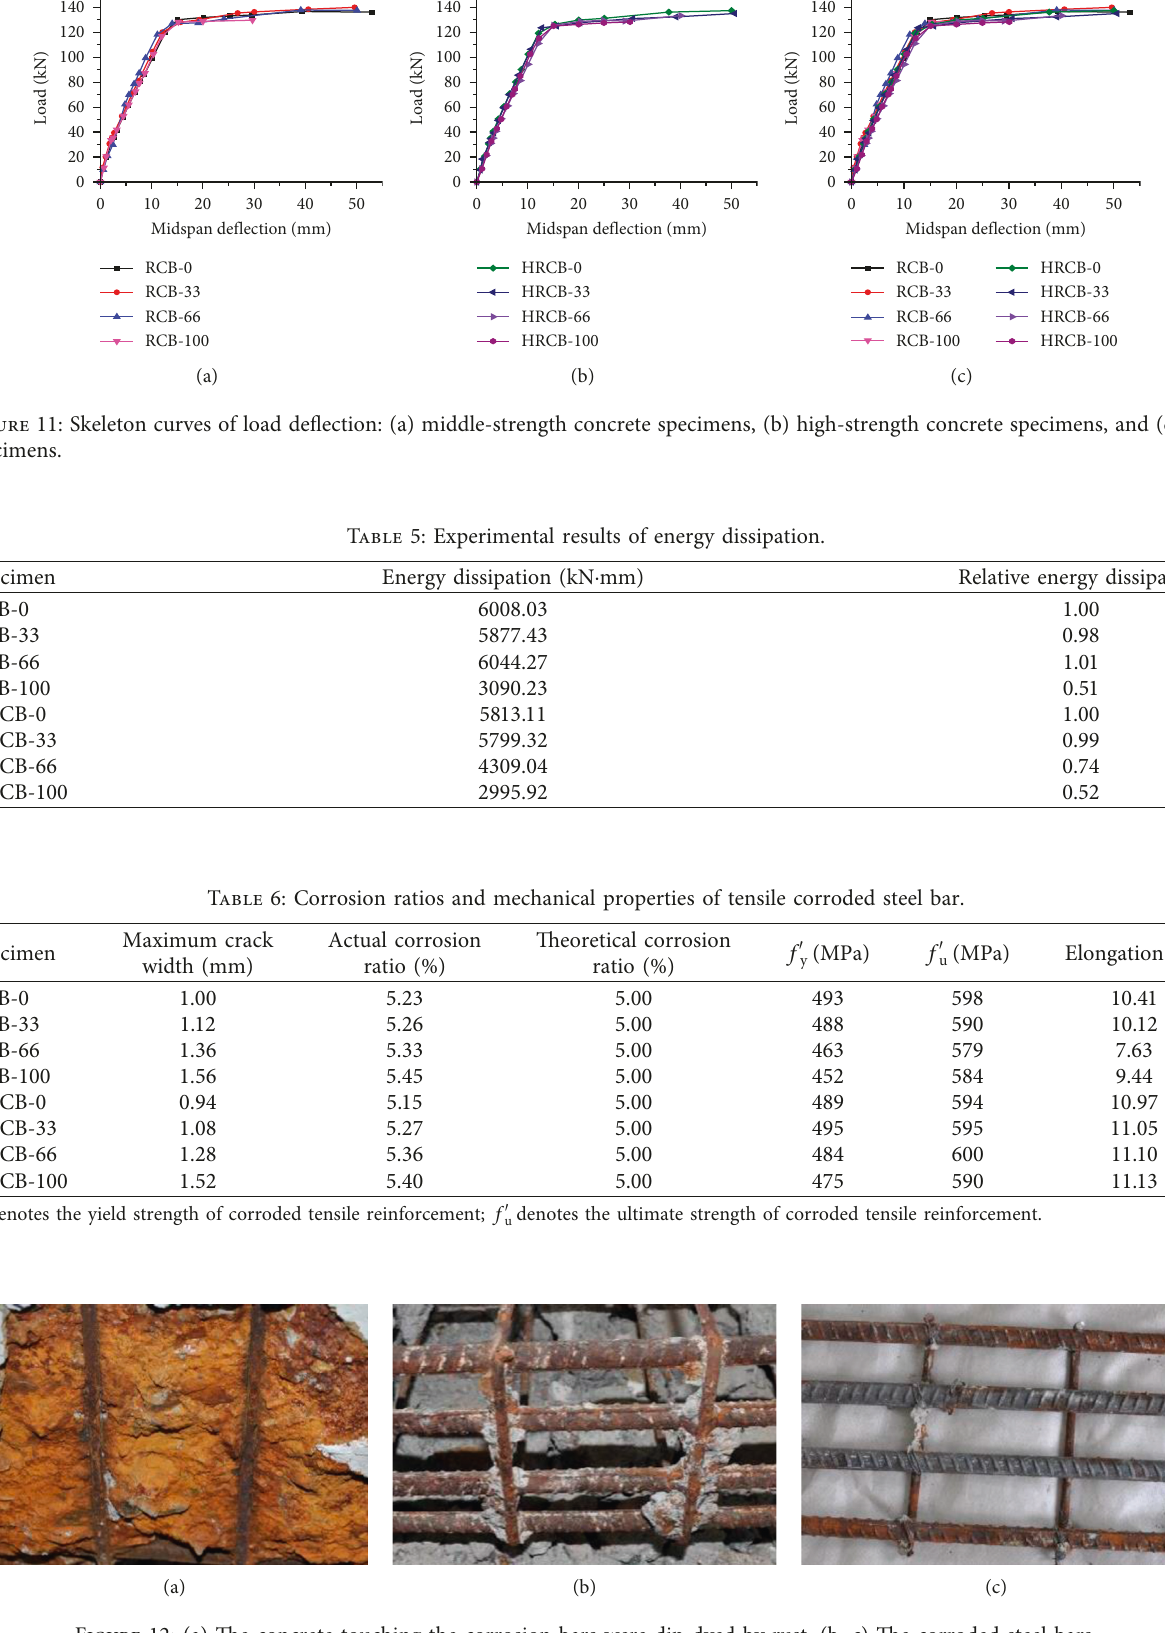
Figure 12: (a) The concrete touching the corrosion bars were dip-dyed by rust. (b, c) The corroded steel